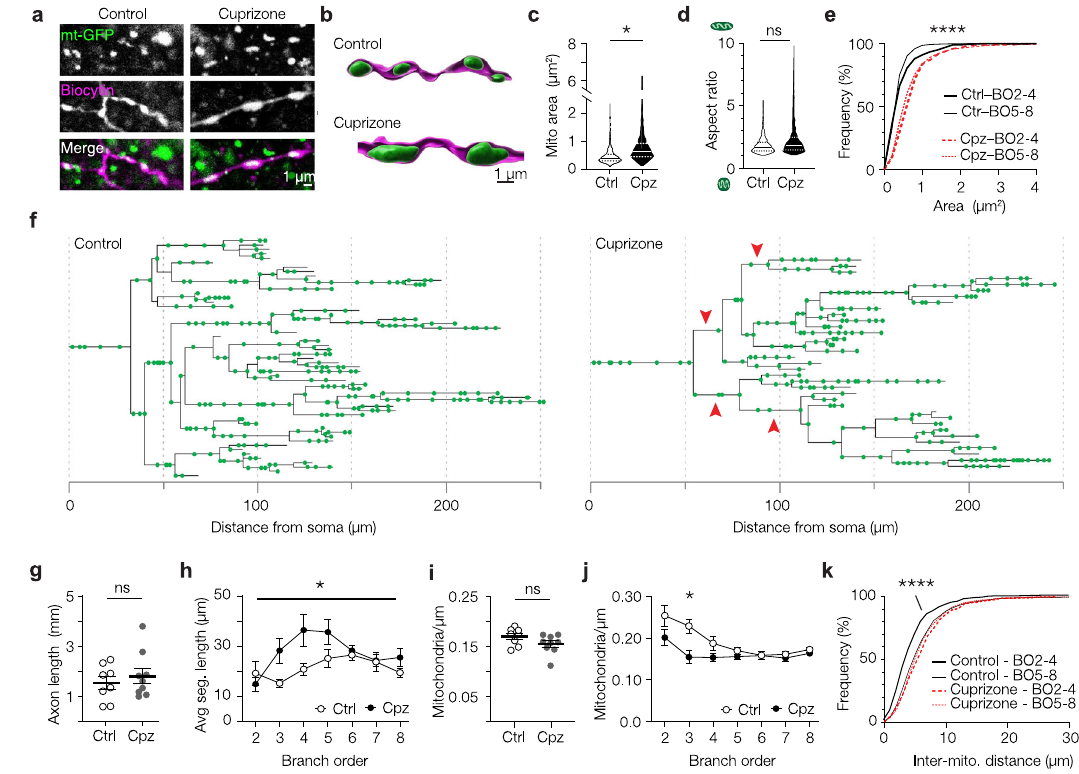
Fig. 3 | Cuprizone-induced demyelination reduces mitochondrial density in proximal PV + interneuron axons. a Example confocal images of mitochondria (mt-GFP) in control (left) and demyelinated axon (right). Similar results were obtained in 7 mice. b 3D rendered images of mt-GFP and biocytin. c Increased mitochondrial size upon demyelination (two-sided nested t-test, * P =0.0440; df = 8; Ctrl, n =5 axons, 805 mitochondria; 5 cells from 3 mice, cuprizone (Cpz), n =5 axons,1218mitochondria;5cellsfrom4mice). d Unchangedmitochondrialaspect ratio in demyelinated axons (two-sided nested t-test, P =0.2962; df = 8; Ctrl, n =5 axons,805mitochondria;5cellsfrom3mice;Cpz, n =5axons,1218mitochondria; 5cellsfrom4mice). e Cumulativedistributionplotsofmitochondrialsizeshowing uniform increase across all branch orders (BO, Kruskal – Wallis test **** P <0.0001; Dunn ’ sposthoctest,AllCtrlvsCpzcomparisons, P <0.0001,CtrlBO2-4vsBO5-8, P =0.8402;CpzBO2-4vsBO5-8, P =0.3932.Ctrl, n =5axons,805mitochondria;5 cells from 3 mice. Cpz, n =5 axons, 1218 mitochondria; 5 cells from 4 mice). f Example axonograms of a control- (left) and a cuprizone-treated (right) PV + interneuron. Red arrowheads indicate examples of second, third or fourth branch orders where mitochondria appear relatively sparse. g Cuprizone treatment induces no change in axonal length (two-sided unpaired t-test , P =0.4918; df = 15; Ctrl, n =8 axons, 5 mice; Cpz, n =9 axons, 5 mice). h Increased segment length in demyelinated PV + axons as a function of branch order (two-way ANOVA; branch